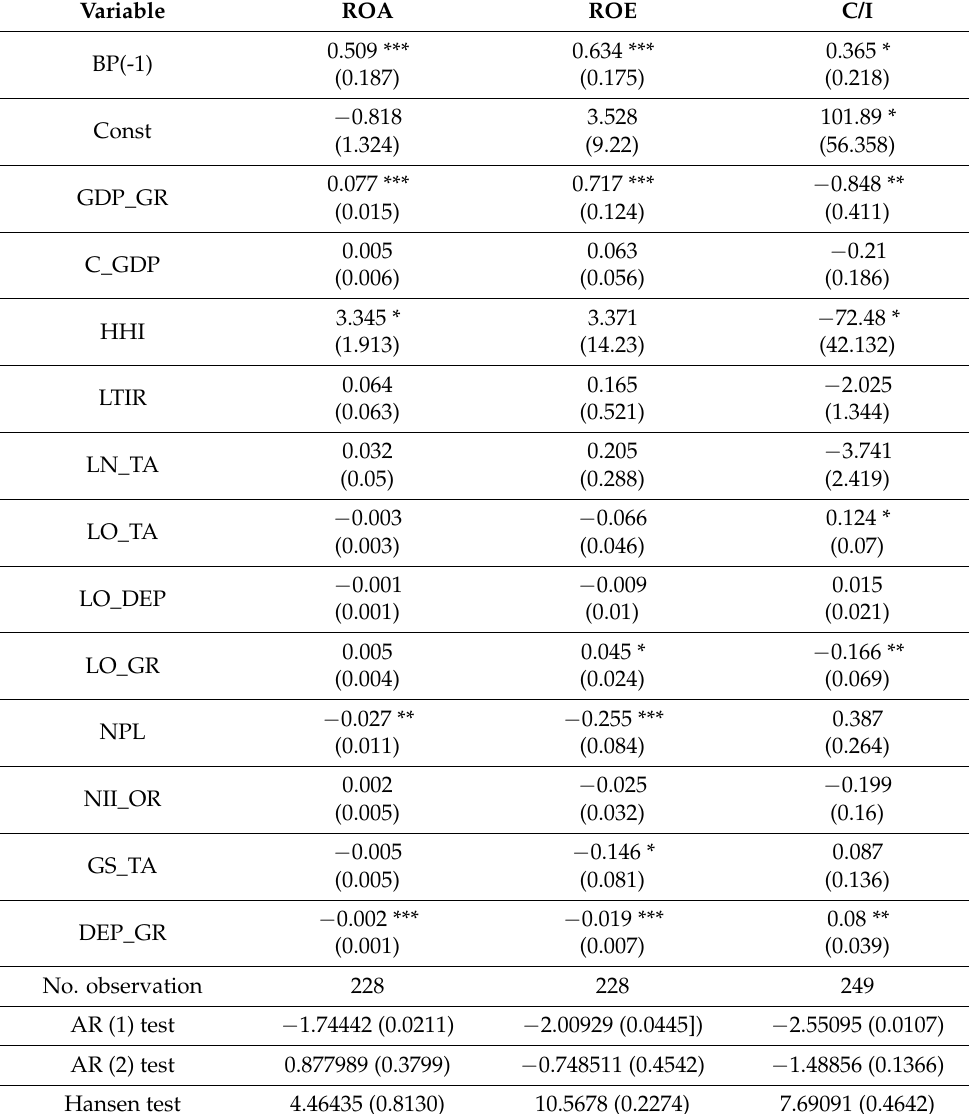
Table 6. Panel model results for performance indicators (ROA, ROE,